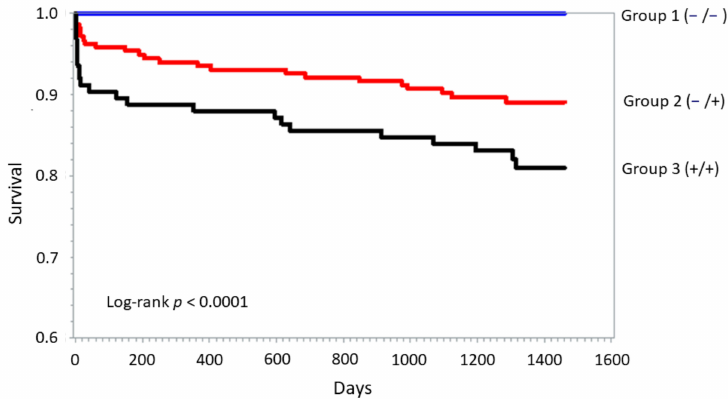
Figure 3. Kaplan–Meier curve analysis for long-term all-cause mortality stratified according to cytochrome c and/or mtDNA detection at hospital admission (group 1 ( − / − ; no mitochondrial biomarker detected) vs. group 2 ( − /+; only one of the two biomarkers detected) vs. group 3 (+/+; both biomarkers detected)). p value was obtained by log-rank test.